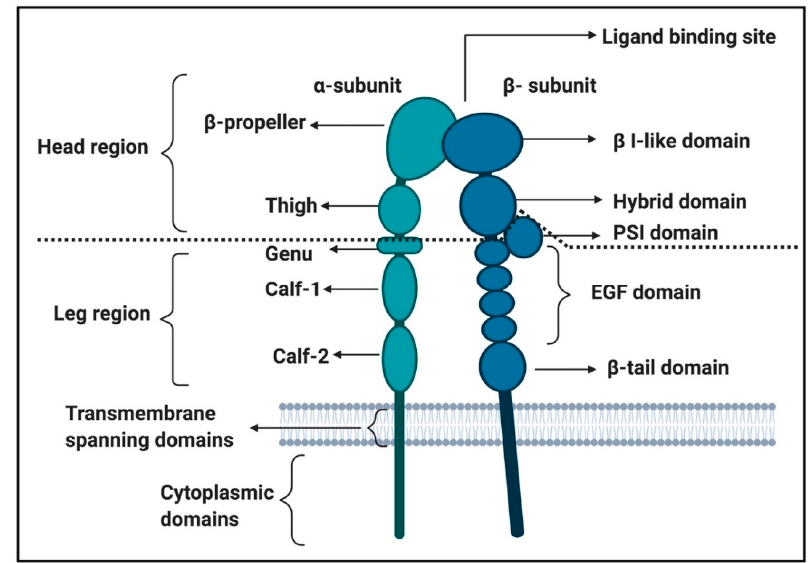
Figure 4. Integrin α IIb β 3 structure adapted from [79,89–91]: This figure was created using BioRender (https://biorender.com/).